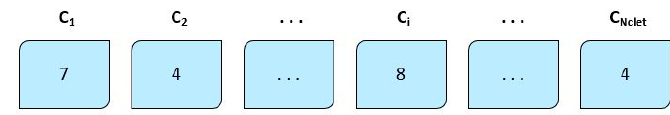
Figure 5. Example of a solution encoding